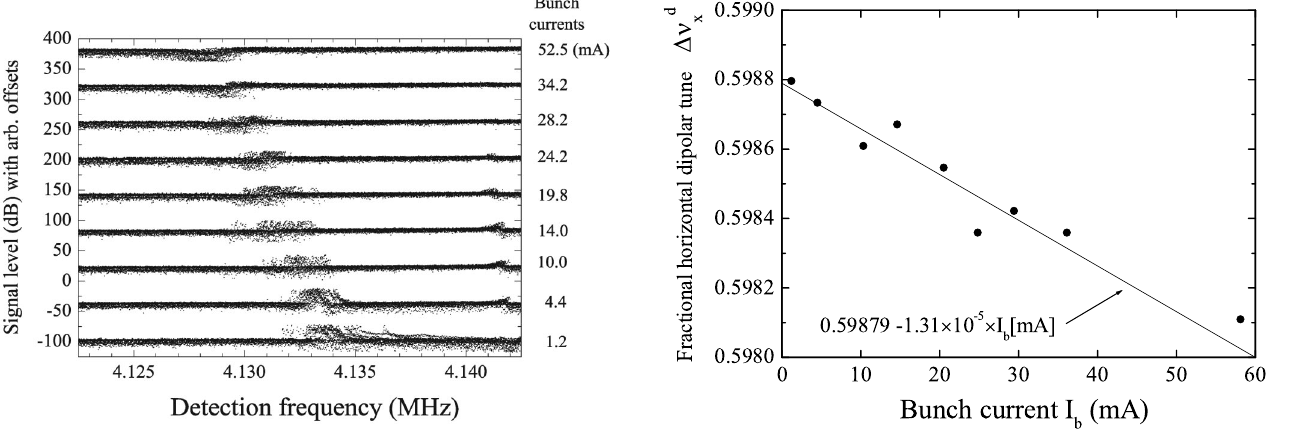
FIG. 8. Measured fractional horizontal tunes of the dipolar oscillations as a function of the beam current per bunch under single-bunch operation.